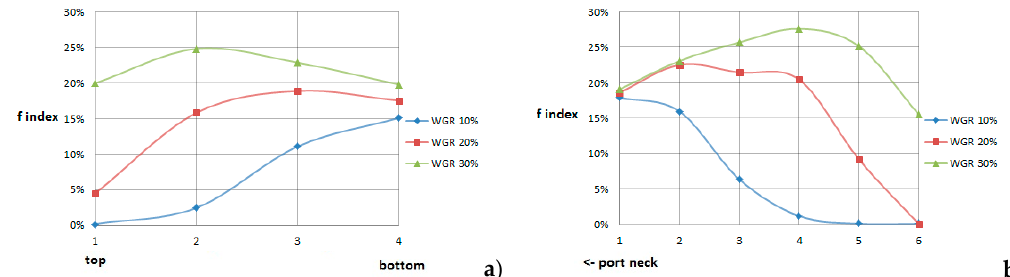
Figure 11. ( a ) Exhaust mean gas fraction at the port neck ( b ) and at the checkers section.